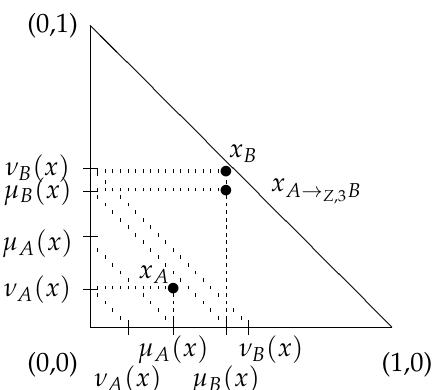
B —the second scenario. → Z ,3